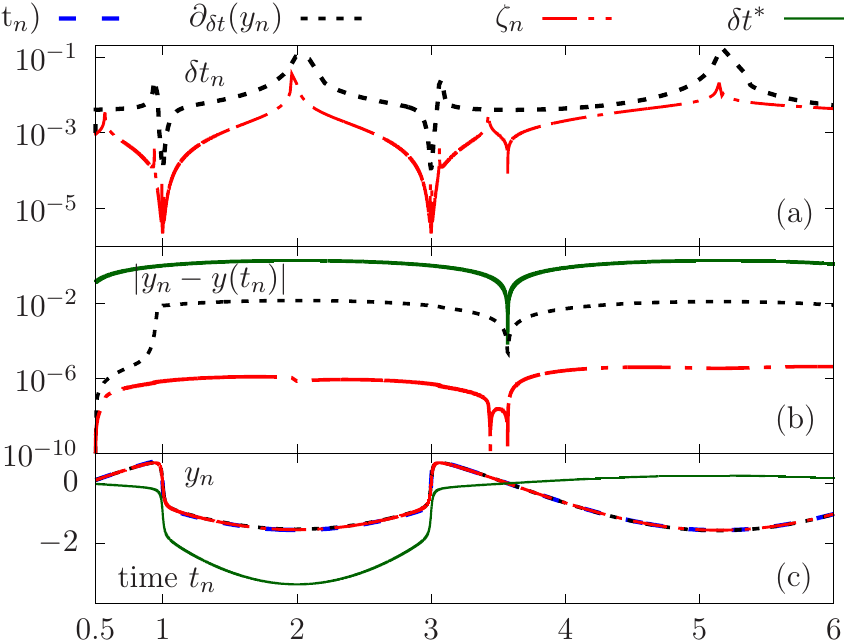
Figure 3. Comparative study of the accuracy between the solutions obtained using different adapta- tion strategies versus a constant time step. Time evolution of the adapted time step ( a ), error ( b ) and computed solution ( c